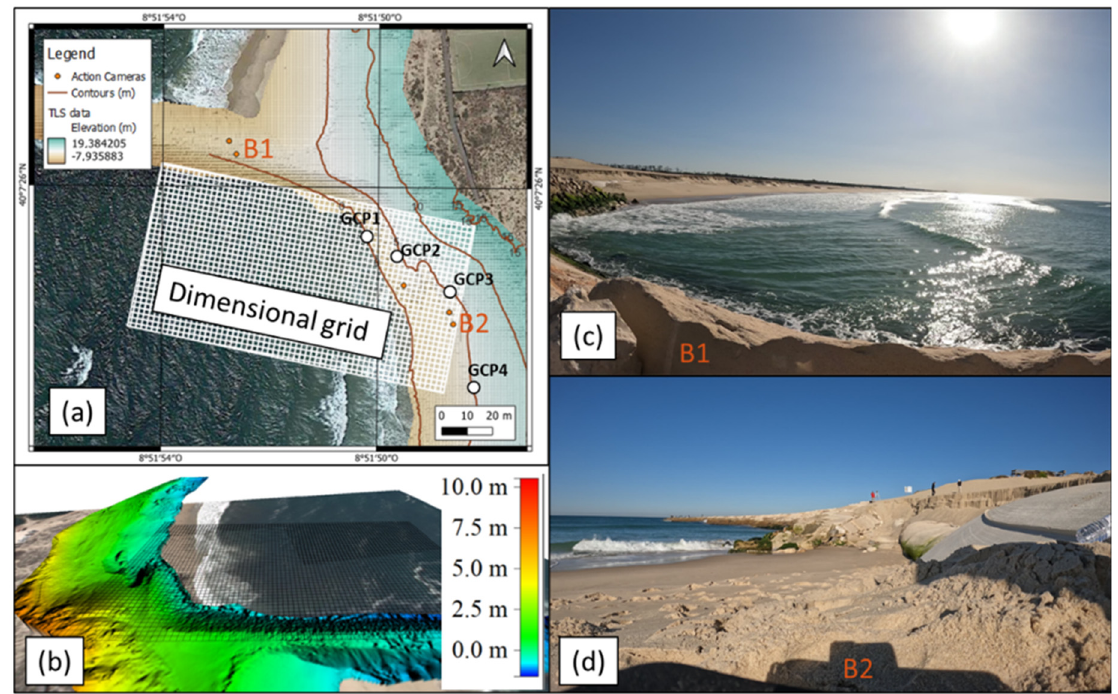
Figure 6. Dimensional features assessed on the Portuguese coast of Cova Gala; ( a ) dimensional grid used for the assessment of physical wave parameters; ( b ) dimensional grid and Digital Terrain Model of the beach; ( c , d ) point of view of the action cameras used to record the wave height